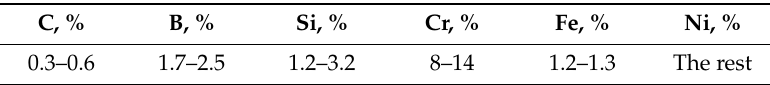
Table 4. The chemical composition of the Ni-based alloy.